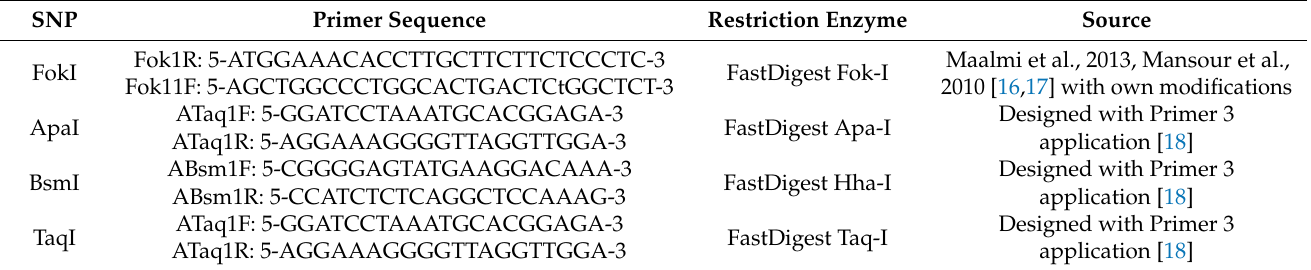
Table 2. Primers for single nucleotide polymorphisms (SNPs) in the VDR gene and restriction enzymes. SNP Primer Sequence Restriction Enzyme Fok1R: 5-ATGGAAACACCTTGCTTCTTCTCCCTC-3 FokI Fok11F: 5-AGCTGGCCCTGGCACTGACTCtGGCTCT-3